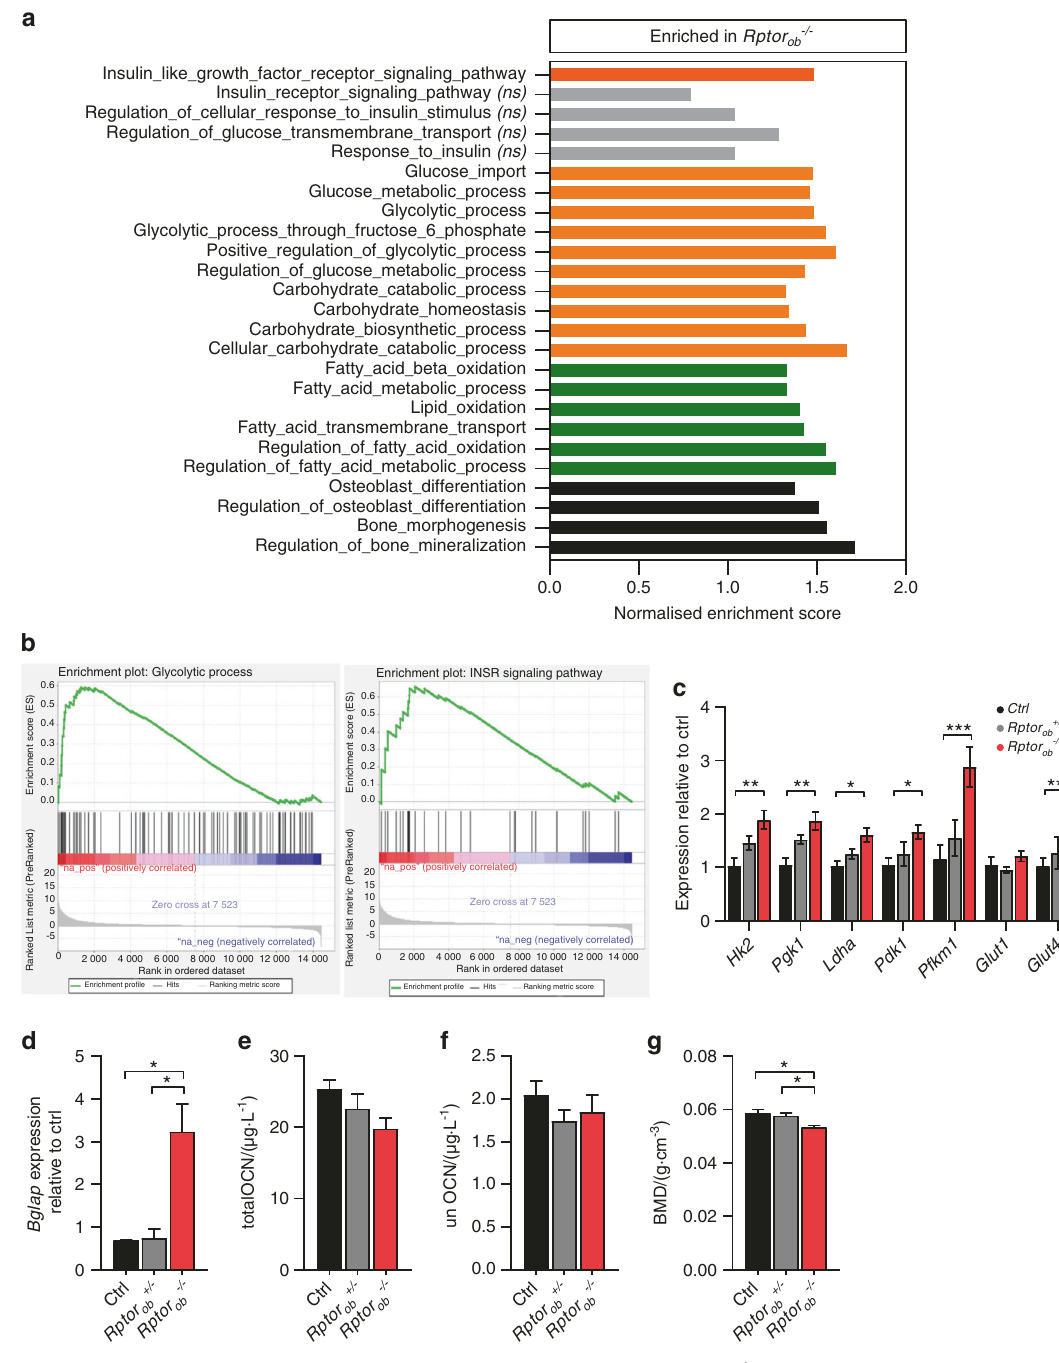
Fig. 7 Increased glycolysis and insulin signaling pathways in the bone of HFD-fed Rptor ob − / − mice. a Gene set enrichment analysis (GSEA) of positively enriched pathways (upregulated) in RNA isolated from combined fl ushed femur and tibia ( n = 5; controls versus Rptor ob − / − ). b Enrichment plots of glycolysis and insulin-like growth factor receptor signaling pathways. c Gene expressions of glycolysis ( HkII , Pgk1 , Ldha , Pdk1 , and Pfkm1 ) and glucose transporters ( Glut1 and Glut4 ) in the fl ushed femur/tibia from HFD-fed mice ( n = 3 – 5/genotype). d Gene expression of Bglap in the fl ushed femur/tibia, normalized to Actb ( n = 3 – 4/genotype). e Serum levels of total osteocalcin (OCN) and f undercarboxylated osteocalcin (unOCN) levels in 18-week-old HFD-fed mice ( n = 7 – 15/genotype). g Whole-body bone mineral density (BMD) measured by DXA ( n = 5/genotype). Data are expressed as mean ± SEM. * P < 0.05, ** P < 0.01, *** P < 0.001, one-way ANOVA with Tukey ’ s post hoc test. a An orange bar indicates pathways relating to glucose metabolism or insulin signaling, a green bar indicates pathways relating to lipid metabolism, and a black bar indicates pathways relating to bone development. Gray bar (ns) = not signi fi hypoglycemia, enhanced glucose tolerance, and increased insulin sensitivity. These bene fi cial metabolic effects were maintained under excess nutrient conditions resulting in protection against HFD-induced obesity and insulin resistance.